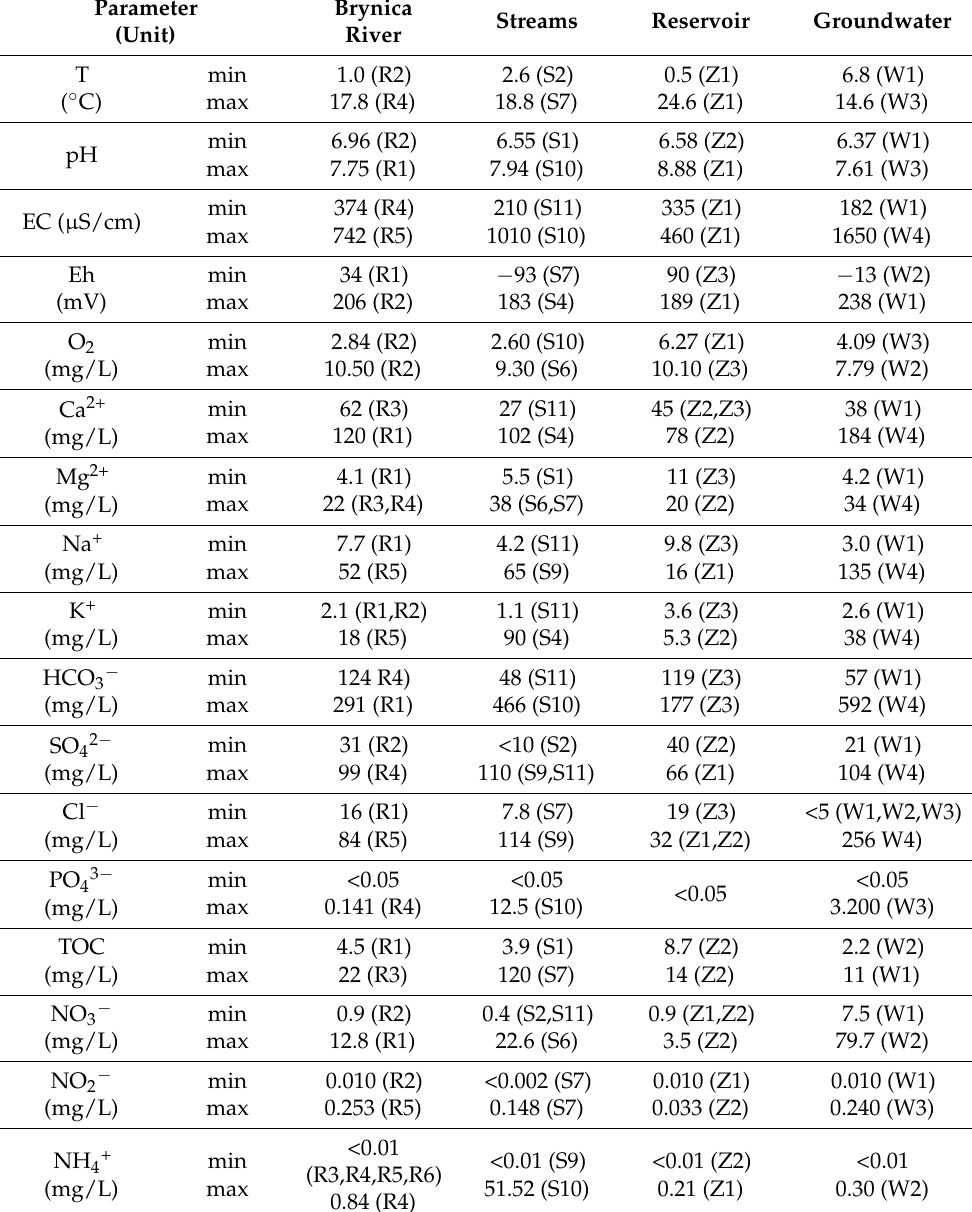
Table 1. Results of measured parameters in sampled water (maximum and minimum